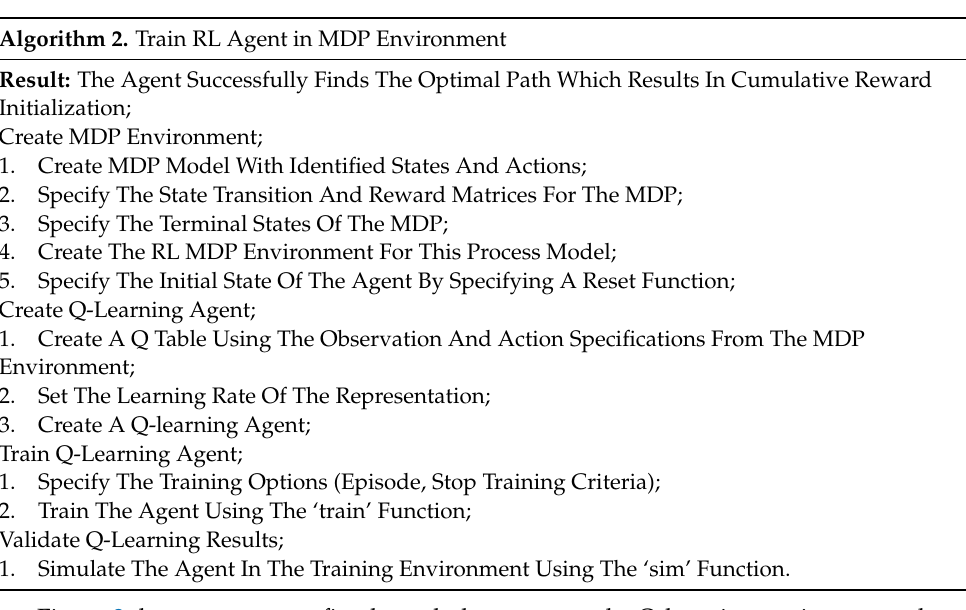
Algorithm 2. Train RL Agent in MDP